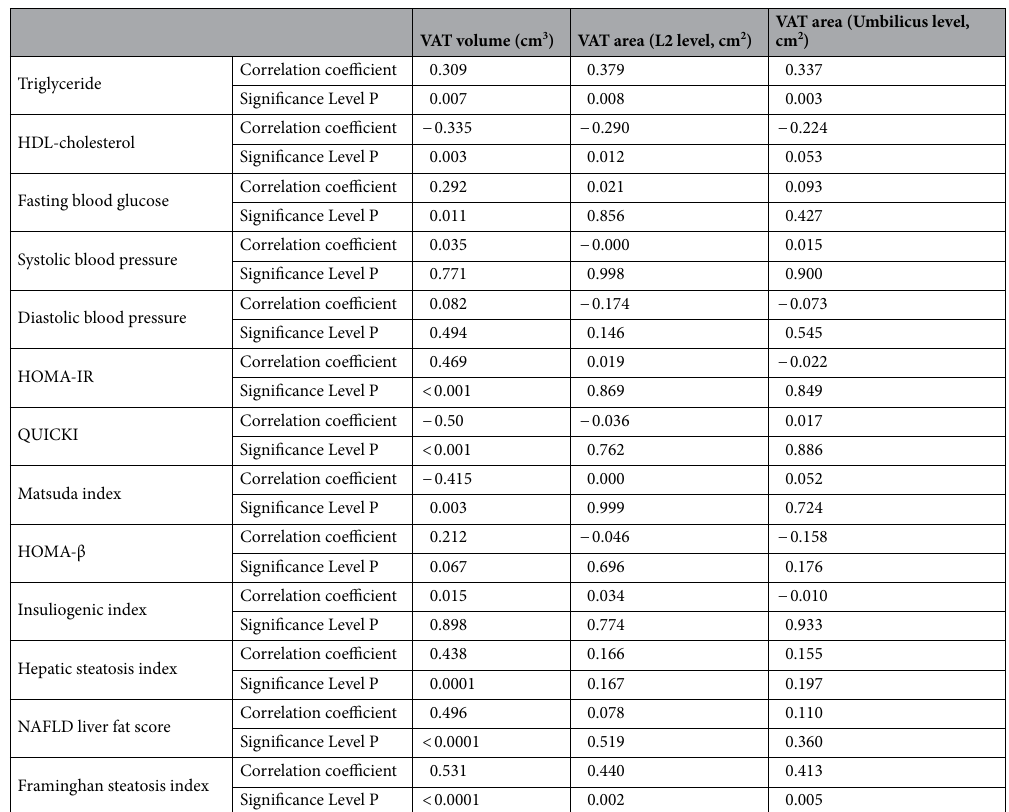
Table 2. Univariable regression analysis between VAT measurement methods to metabolic risk factors. VAT, visceral adipose fat tissue; HDL, high-density lipoprotein; HOMA-IR, homeostatic model assessment of insulin resistance, HOMA-β, homeostatic model assessment of β-cell function; QUICKI, quantitative insulin sensitivity check index; NAFLD, nonalcoholic fatty liver